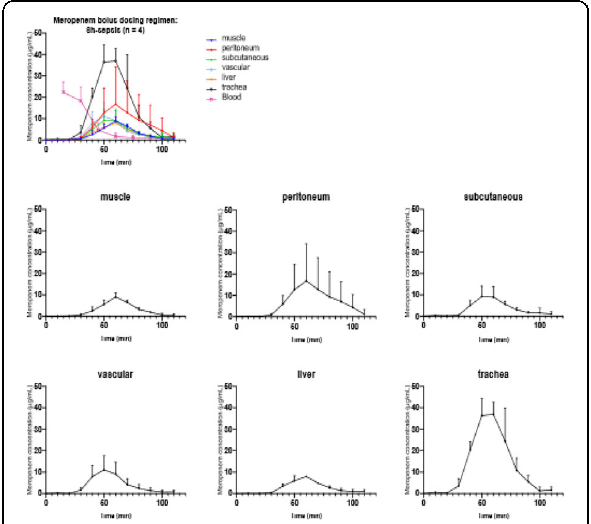
Fig. 1 (abstract 001019). Tissue concentration/time profiles following a meropenem bolus in septic rats at 6h